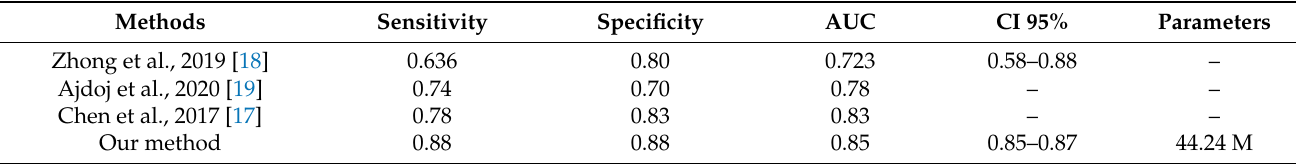
Table 4. Comparison with the three cited methods used to classify the clinical severity of prostate